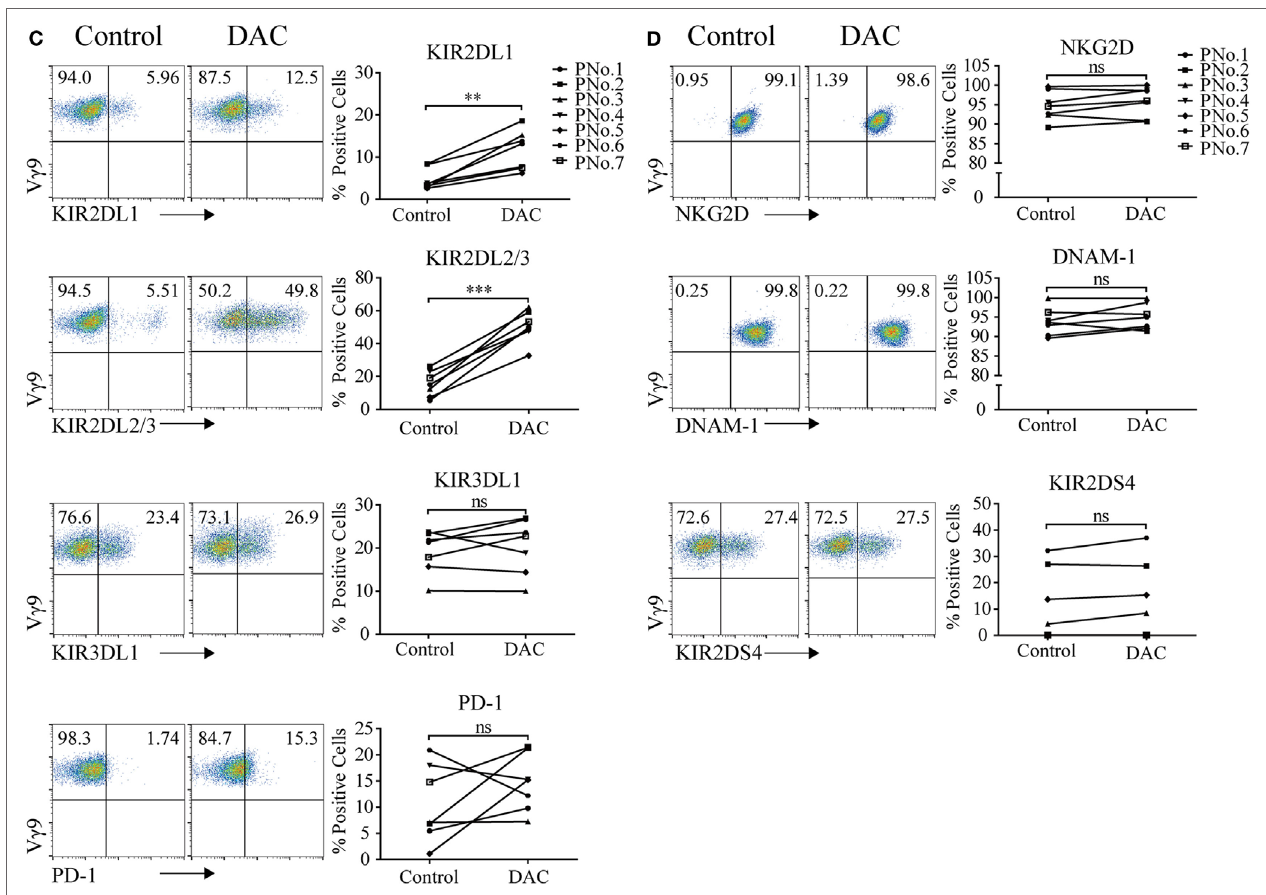
FigUre 2 | Decitabine treatment reduced gamma delta ( γδ ) T cell cytotoxicity to tumor cells and upregulated inhibitory receptor expression on γδ T cells. (a) Cytotoxicity assay protocol. (b) Cytotoxicity of expanded γδ T cells treated with increasing doses of DAC against Raji, K562, and SKM-1 cells in two effector to target cell (E:T) ratios (** p < 0.01; *** p < 0.001; ns, not significant; n = 7). (c,D) The effect of DAC on inhibitory and activating receptors expressed on γδ T cells. γδ T cells were incubated with 0.5 µM DAC for 48 h. Annexin-V-negative cells were gated and analyzed for surface marker expression (** p < 0.01; *** p < 0.001; ns, not significant; n =